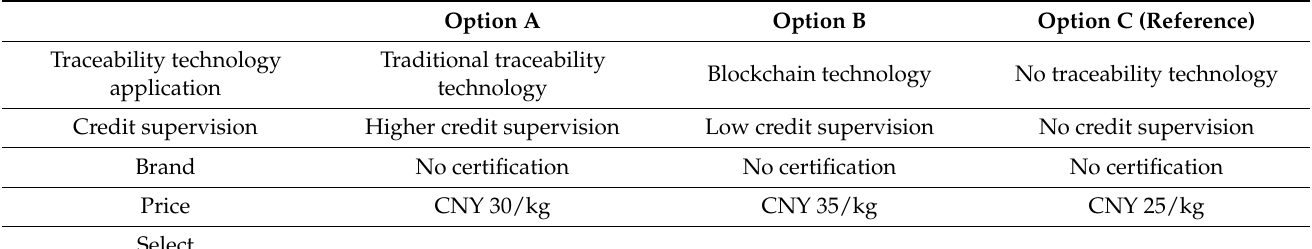
Table 2. Selection set example.